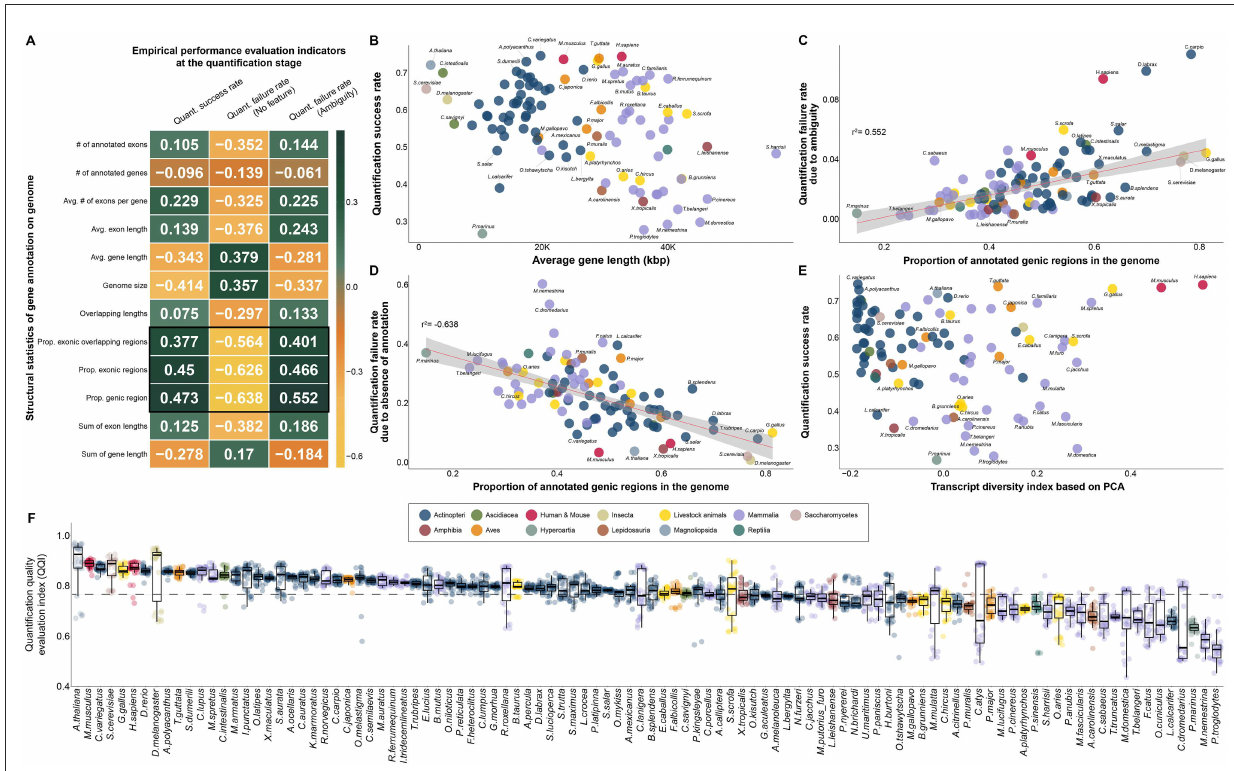
FIGURE5 Selection of empirical effective indicators in the quantification process and investigation of correlation with complexity of transcripts in annotation for quality evaluation of gene annotation in diverse species. (A) Correlation between 12 characteristics of gene annotation and 3 quality evaluation indicators obtained empirically in the quantification process. (B) Scatter plot between average gene length and quantification success rate. (C) Association between the proportion of annotated genic regions in the genome and the rate of quantification failure due to ambiguity. (D) Correlation between the percentage of annotated genic regions in the genome and the rate of quantification failure due to the absence of annotation. (E) Independence between transcript diversity index, a proposed qualitative quality evaluation metric, and quantification rate, a quantitative quality evaluation index. (F) Differences in QQI, an empirical quality index obtained at the quantification stage, in all species. (B–F) The colors in the figure share group information separated by class taxonomic level, except for human-mouse and eight livestock